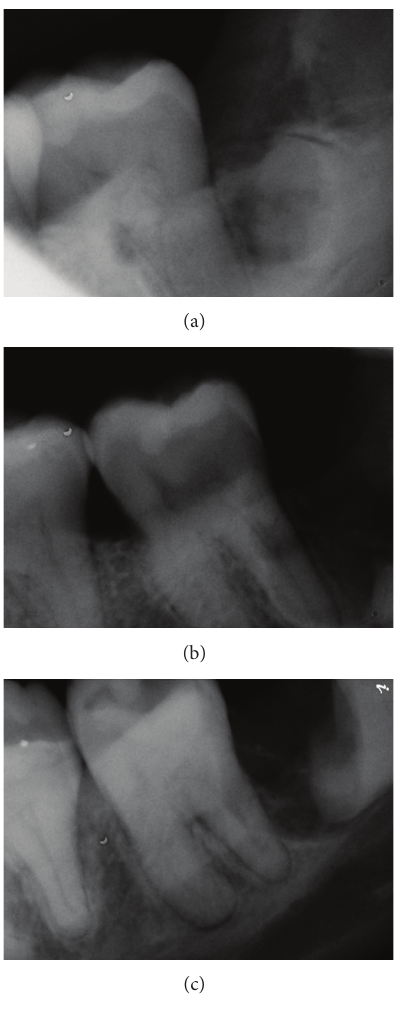
Figure 3: Lower left MTM: (a) after amputation of the crown; (b) after reducing the distoocclusal section of the remaining stump; (c) after an additional cut and removal of the mesial portion of the tooth, to create sufficient clearance to the second molar.